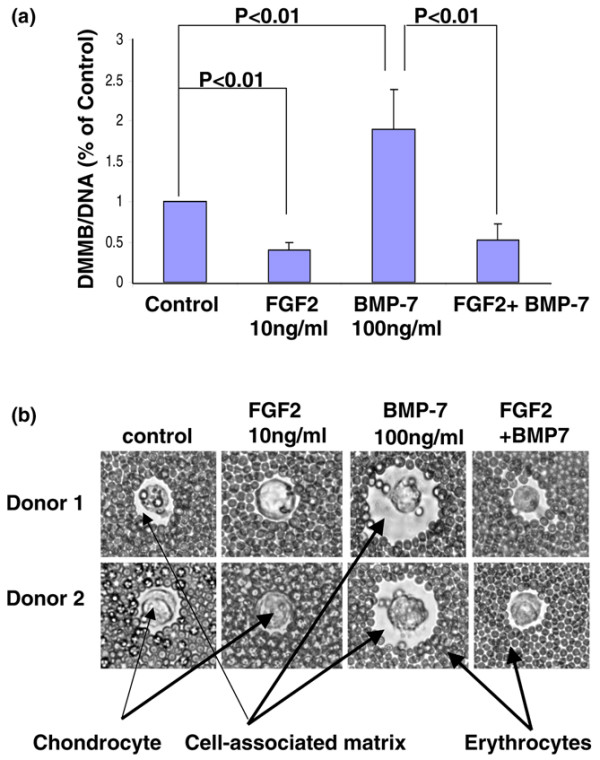
Fibroblast growth factor 2 antagonizes BMP7-mediated stimulation of proteoglycan accumulation in the cell-associated matrix. (a) Nucleus pulposus cells isolated from bovine intervertebral disc were cultured for 21 days in 1.2% alginate beads in serum-free medium with mini-insulin–transferrin–selenium (control) or the control medium plus 10 ng/ml fibroblast growth factor 2 (FGF2), 100 ng/ml BMP7, or 10 ng/ml FGF2 combined with 100 ng/ml BMP7. At the end of the culture period the beads were dissolved in sodium citrate, and cell pellets containing the cells and their cell-associated matrix (CM) were separated by centrifugation. The amount of proteoglycan in the CM was measured by dimethylethylene blue assay and normalized to cell numbers using DNA measurement (DMMB/DNA). Samples were measured in triplicate and expressed as a percentage of the day 21 control cultures. Error bars represent three different donors in three separate experiments (Fig 6A). (b) Nucleus pulposus cell pericellular matrix production after alginate culture for 21 days in the presence or absence of FGF2, BMP7 or the combination of both factors was measured in an exclusion assay as described in Materials and methods. A representative sample was photographed using an inverted phase-contrast microscope. The CM can be seen excluding the erythrocytes from the cell plasma membrane (original magnification × 400).